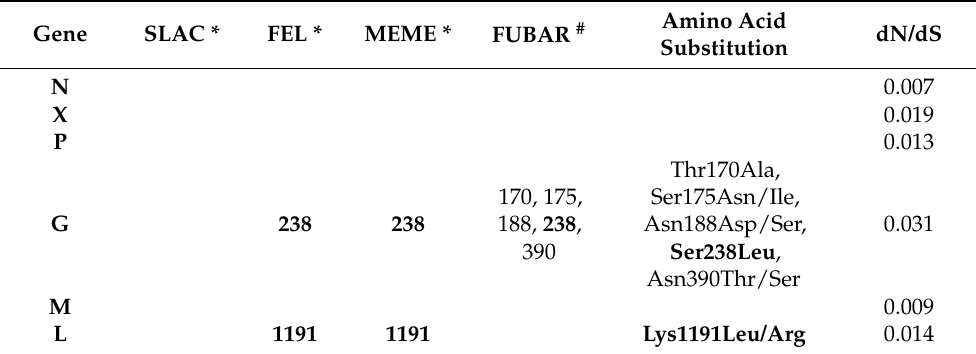
Table 2. Selection pressure analysis showing the position of positively selected codons in the alignment of VSBV-1 genomes. Codons corresponding to amino acid positions found to be positive by at least three approaches are listed in the table. Amino Acid dN/dS Gene SLAC * FEL * MEME * FUBAR # Substitution N 0.007 X 0.019 P 0.013 170, 175, G 238 238 188, 238 , 390